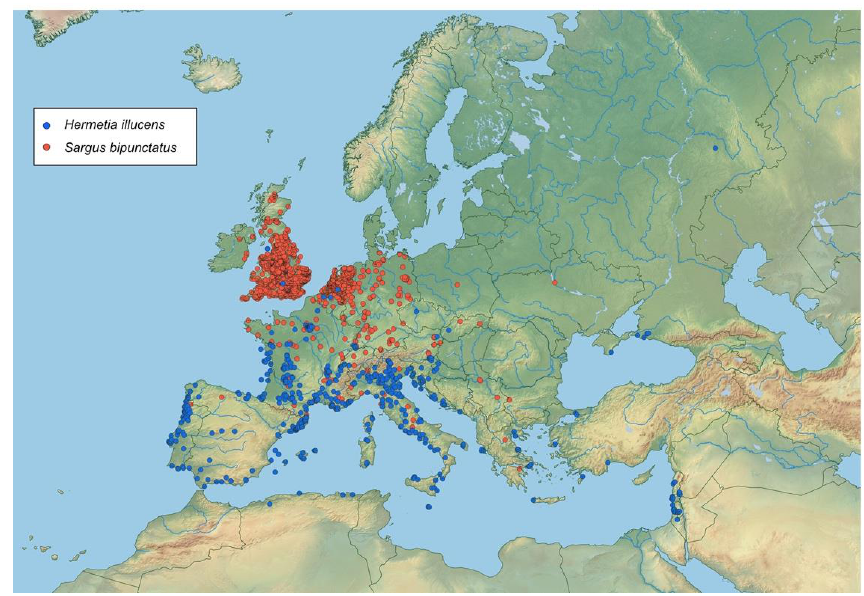
Figure 3. Distribution of Hermetia illucens and Sargus bipunctatus in Western Palearctic, based on data coming from GBIF and iNaturalist.